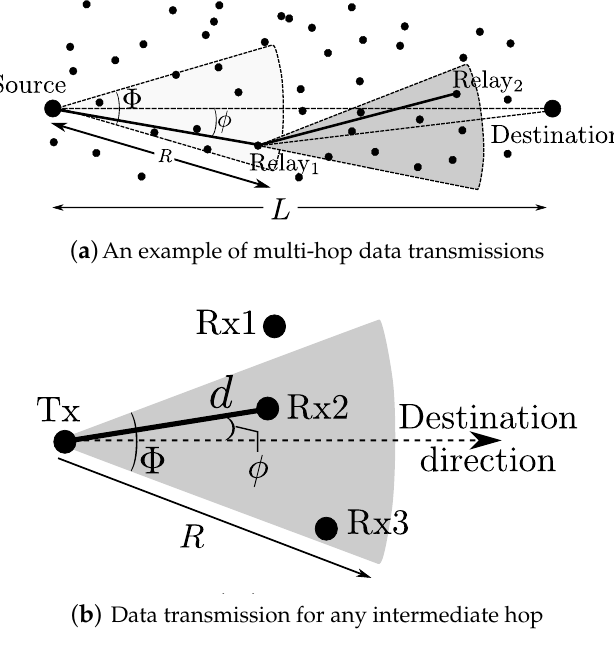
Figure 1. System